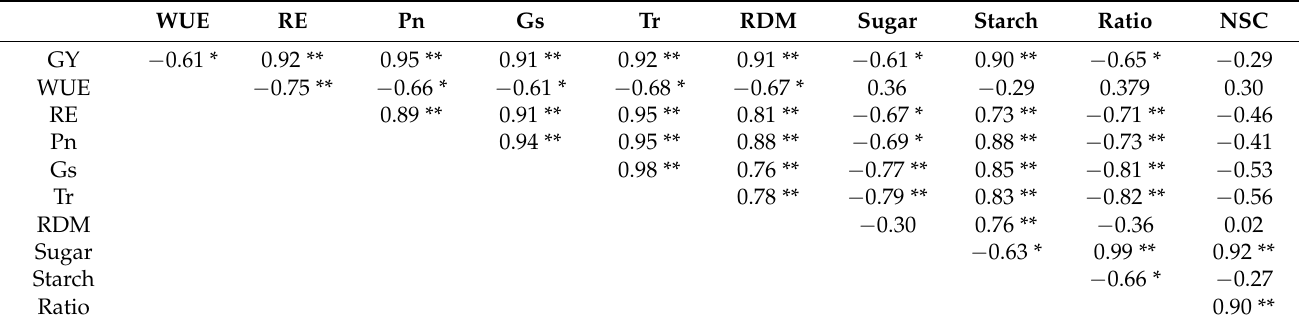
Table 1. Correlation between yield and physiological indices under the two water